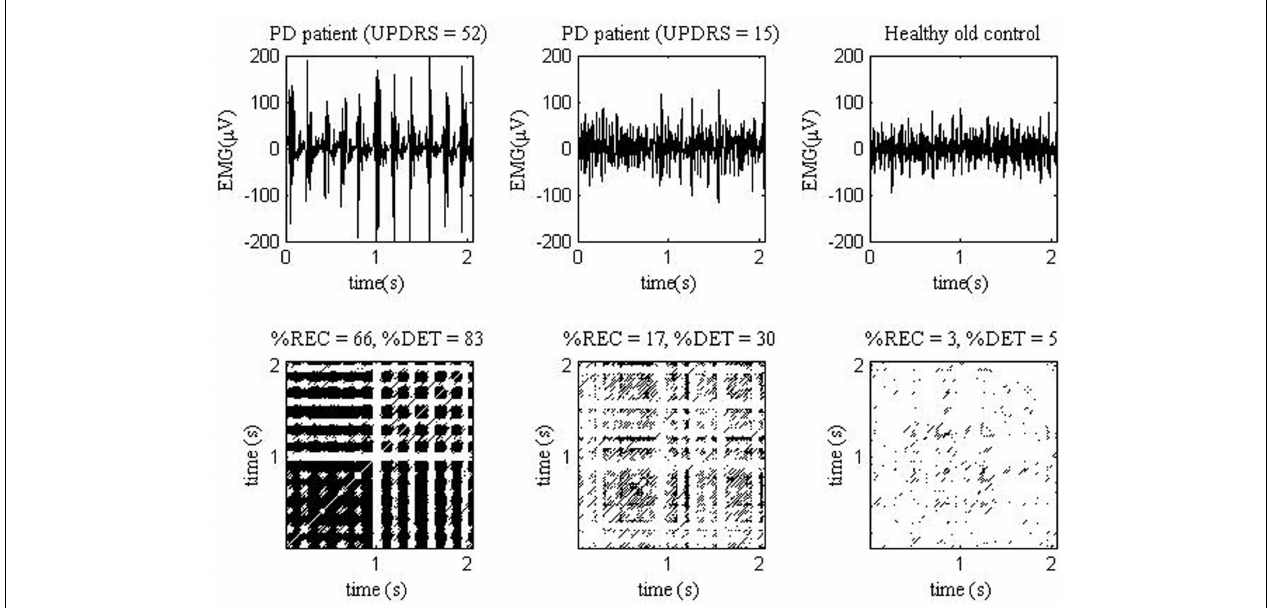
FIGURE 1 | EMG signals (top) measured from one PD patient with UPDRS = 52 (left), one PD patient with UPDRS = 15 (middle), and one healthy old control (right) .The EMG measurements were analyzed in study (47).The corresponding EMG recurrence plots